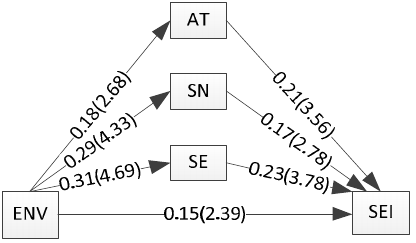
Figure 2. Structural equation model. Notes: ENV = environmental values; SEI = sustainable entrepreneurial intention; AT = attitude; SN = social norms; SE = self-efficacy. Table 2. Results of the direct effect among the constructs and proposed hypotheses.